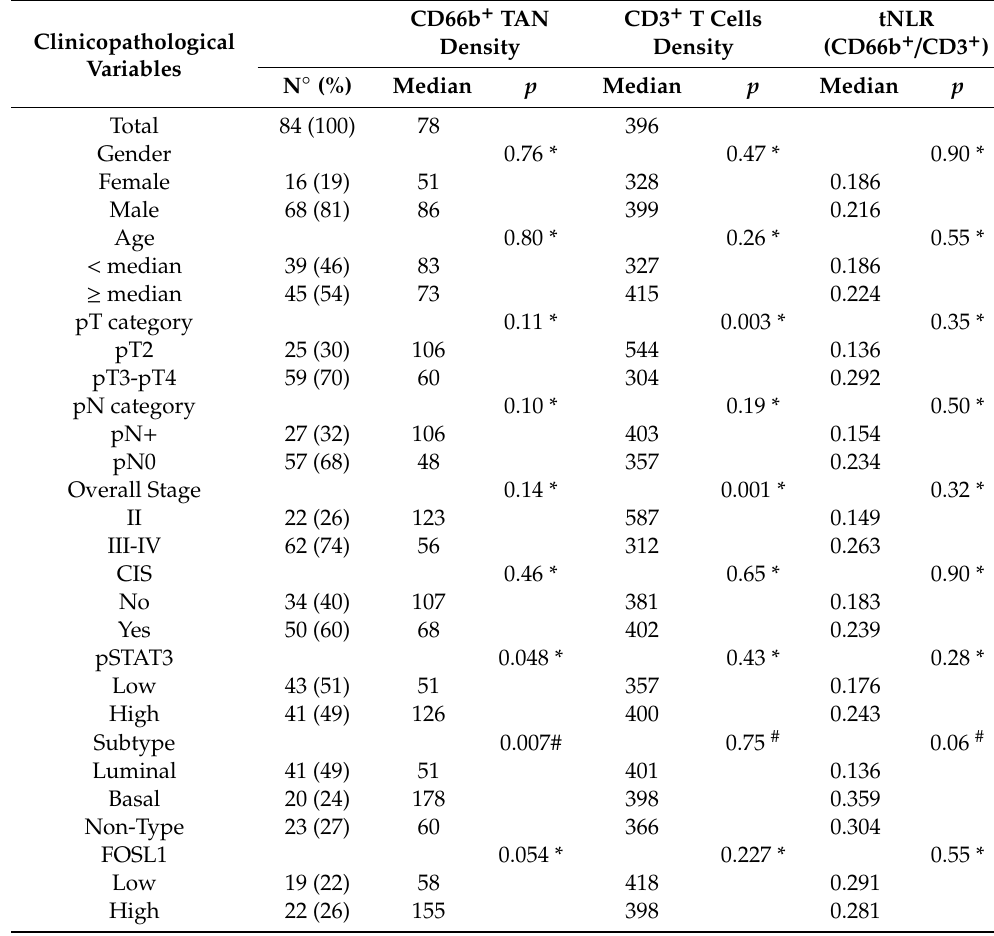
Table 3. Association analysis between immune cell infiltration and clinic-pathological data. tNLR, tissue NLR; CIS, carcinoma in situ; p value estimated by # Kruskal-Wallis test or * Mann-Whitney